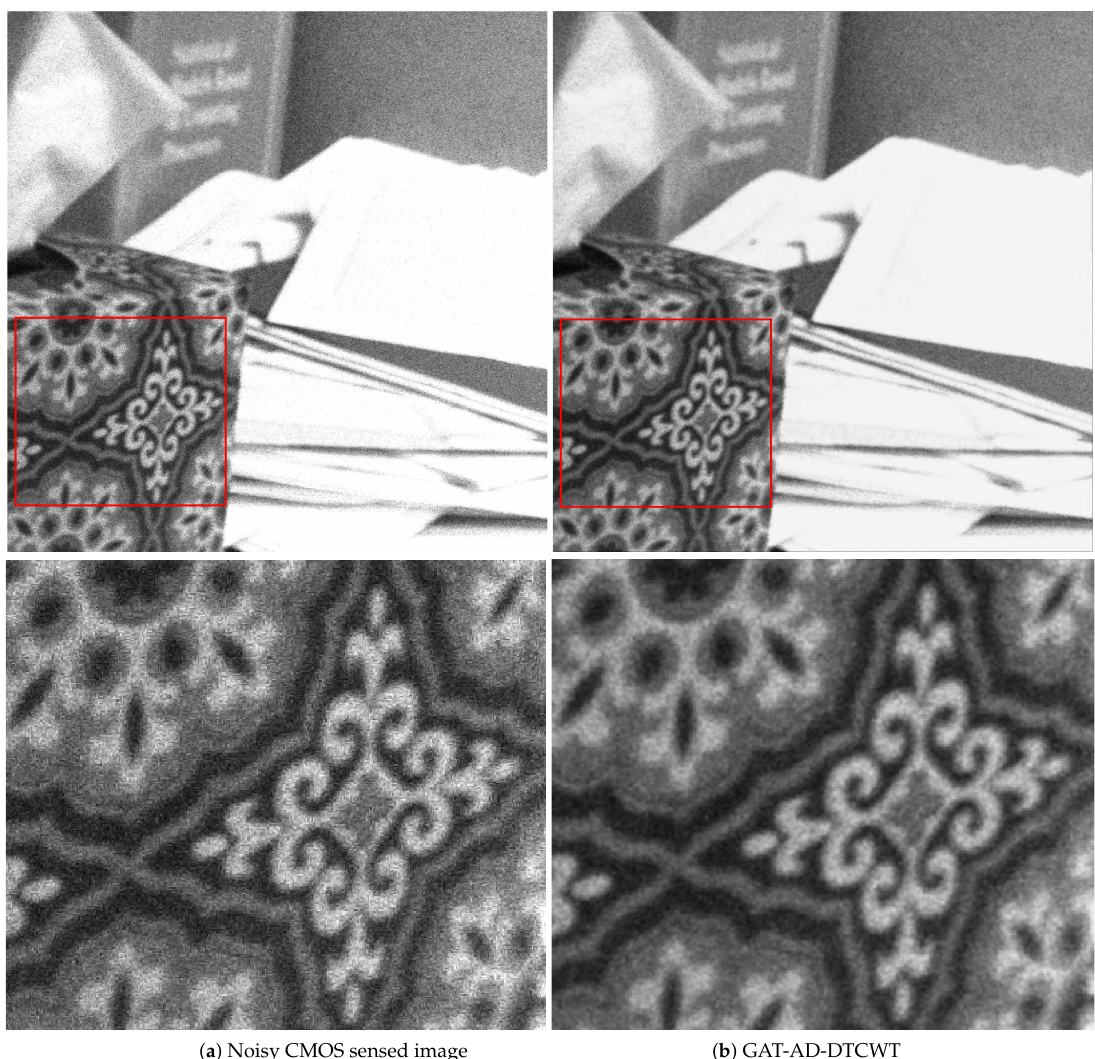
Figure 11. Performance analysis of the proposed GAT-AD-DTCWT on a noisy image obtained from RENOIR dataset [58] which contains noisy images from CMOS sensors corrupted by real sensor